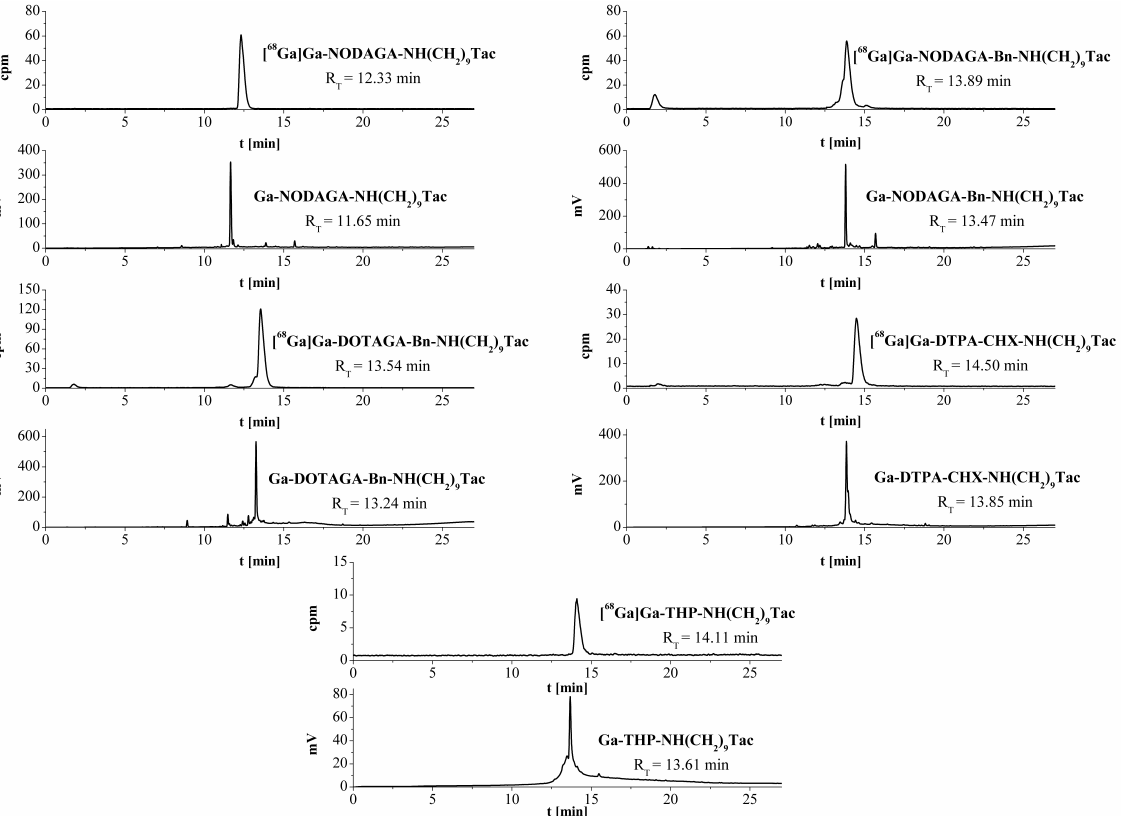
Figure 2. HPLC chromatograms of reaction mixture of the obtained radioconjugates and their ref ‐ erence compounds. Table 1. t R values of conjugates (system 2, UV detection), radioconjugates (system 1, gamma de ‐ tection) and reference compounds (system 1, UV detection), and logD 7.4 values determined for ra ‐ dioconjugates.